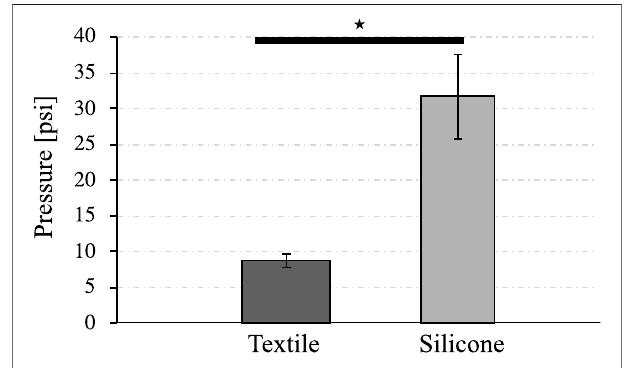
FIGURE8 | Air pressure needed to achieve full bending performance for both types of actuators. The symbol + represents a signi fi cant difference between the two groups based on statistical analysis tests ( p < 0.05).